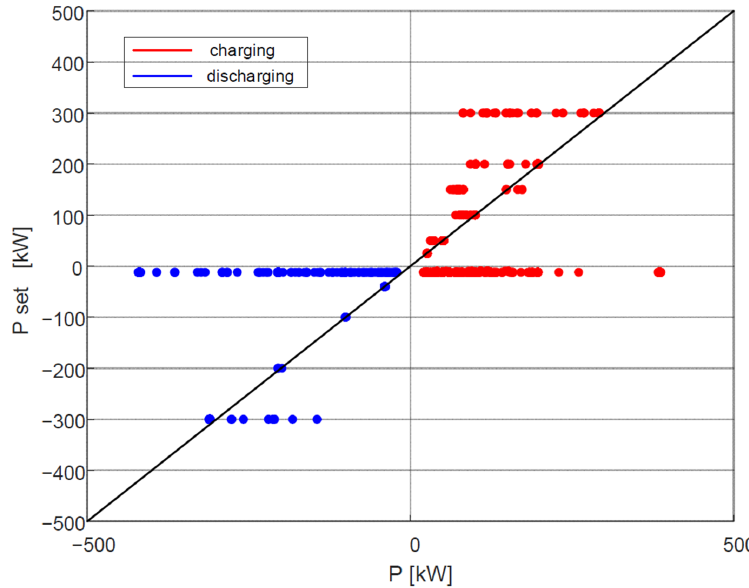
Figure 8. Dependence of storage power on the operation plan.